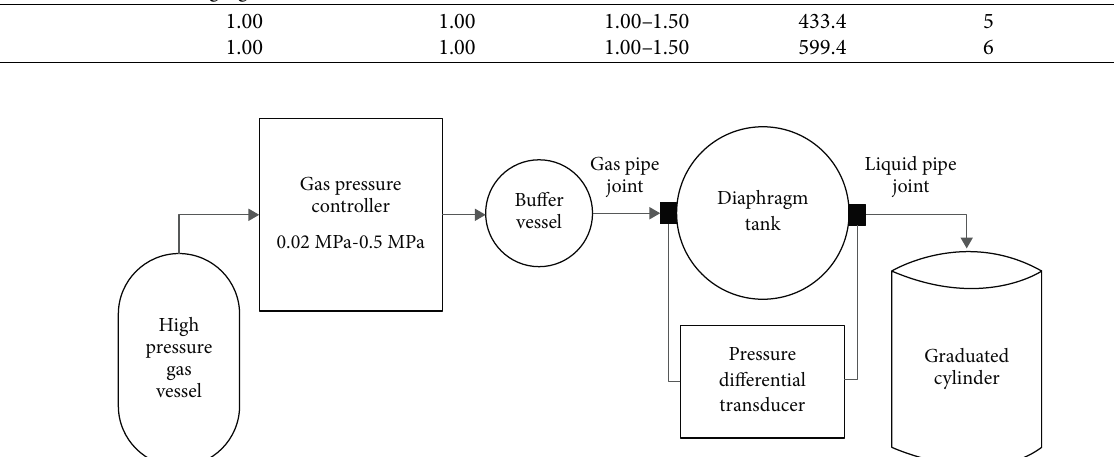
Figure 3: Schematic diagram of the reversal test process.